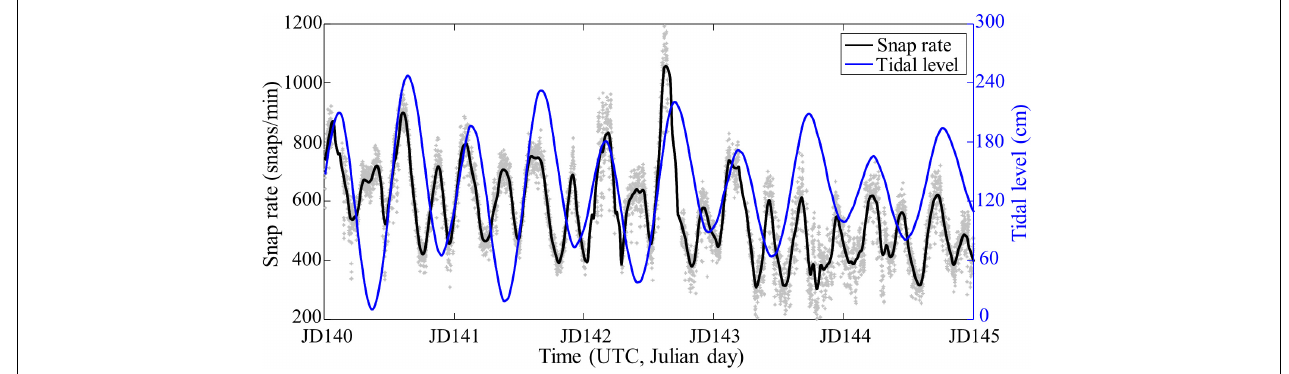
FIGURE 8 | Reproduction of Figure 6A at VLA1 (gray dots and black line). The extrapolated tidal level (blue line) is superimposed for comparison.